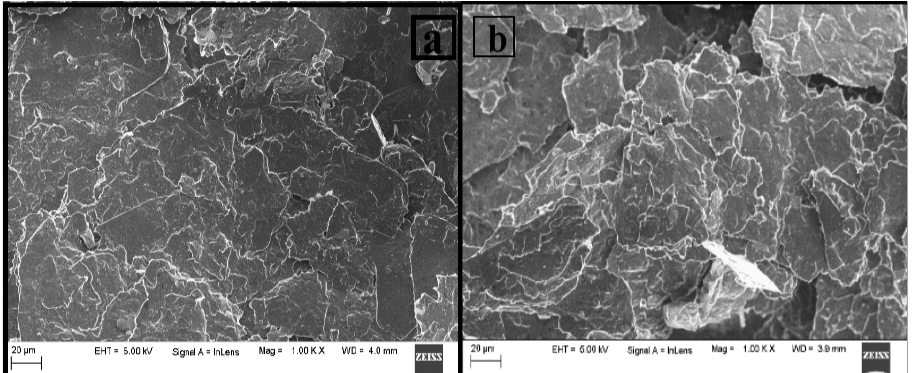
Figure 1. FE ‐ SEM images of ( a ) BCPE and ( b ) EPGNLCPE.